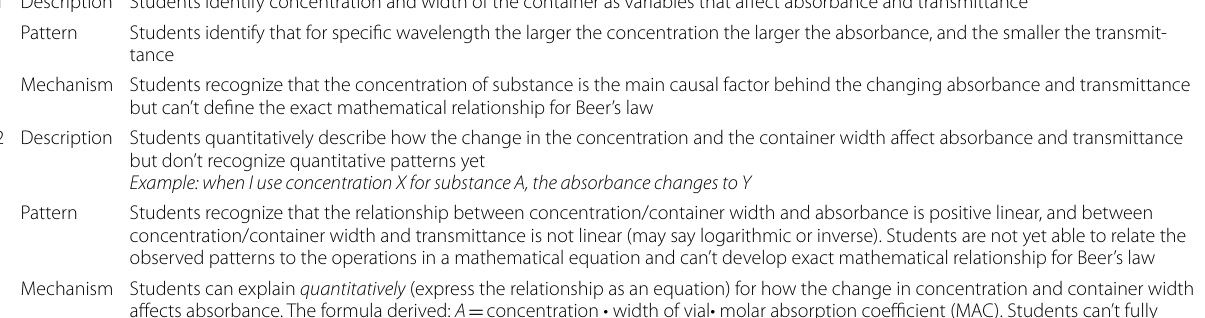
Table 3 Interview coding rubric for Beer’s Law simulation 1 Description Students identify concentration and width of the container as variables that affect absorbance and transmittance